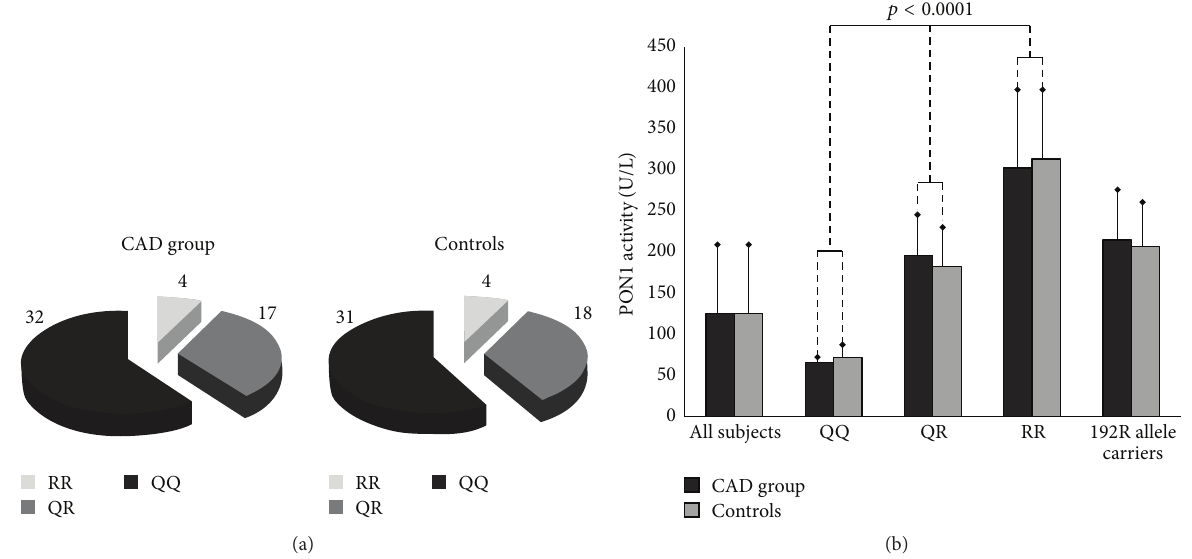
Figure 1: The L55M polymorphism of the PON1 gene: (a) the percentage distribution of PON1 genotypes in patient and control groups; (b) the association of Q192R polymorphism with serum PON1 activity.